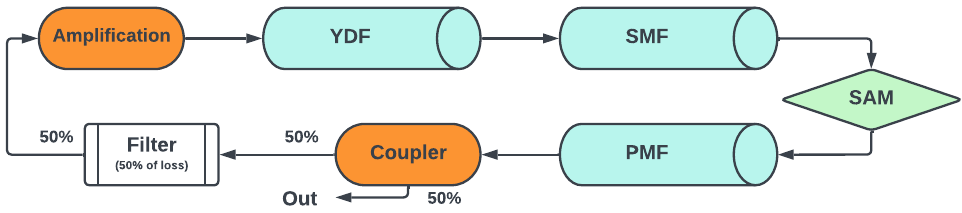
Figure 3. The algorithm used for the simulations of the experimental setup. YDF—double- clad Yb-doped fiber, SMF—single-mode fiber, PMF—polarization-maintaining fiber, SAM—self- amplitude modulator.